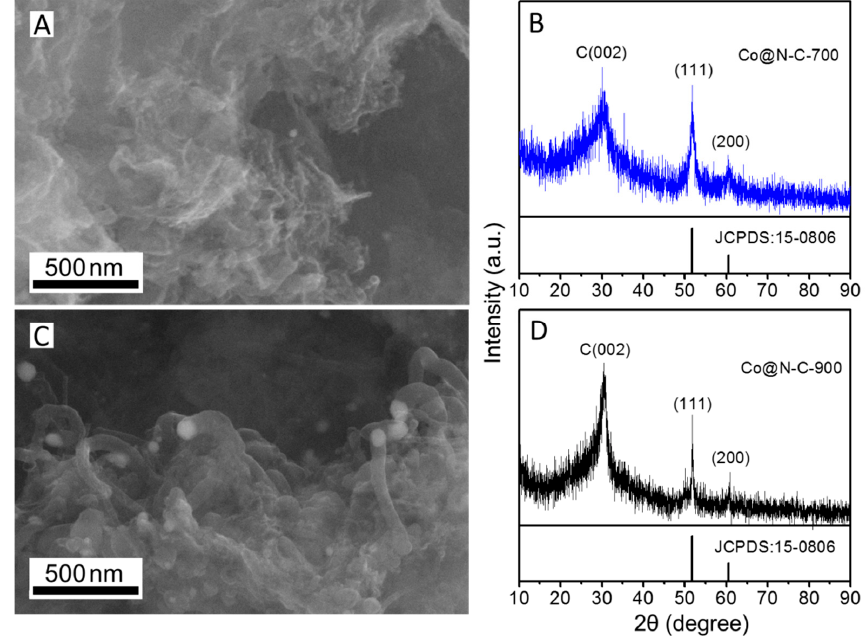
Figure 2. ( A ) SEM image and ( B ) XRD pattern of Co@N-C-700, ( C ) SEM image, and ( D ) XRD pattern of Co@N-C-900.